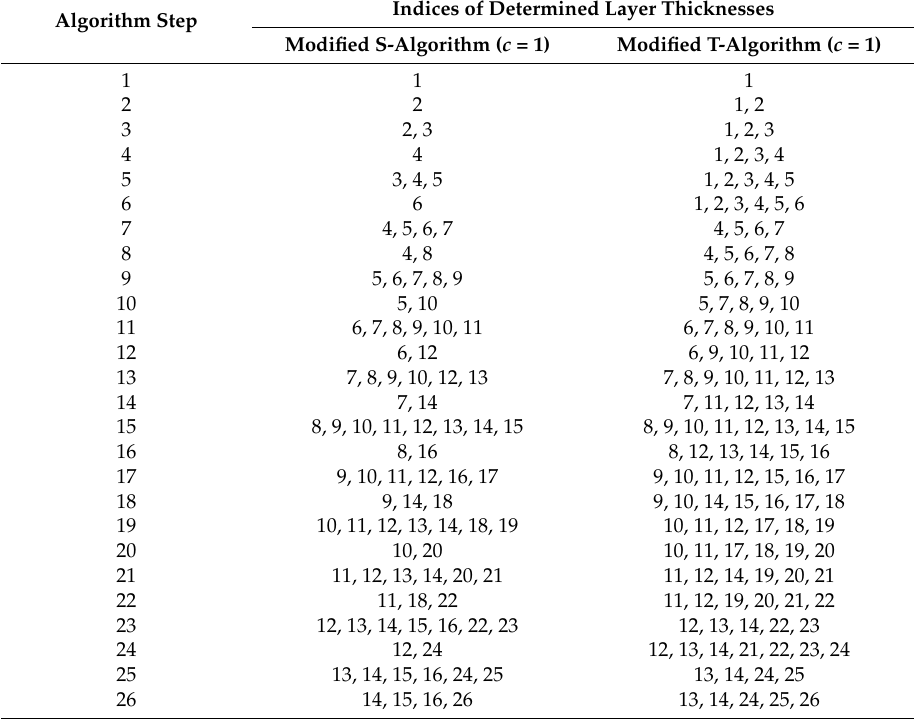
Table 1. Indices of the determined layer thicknesses for the modified S- and T-algorithms.